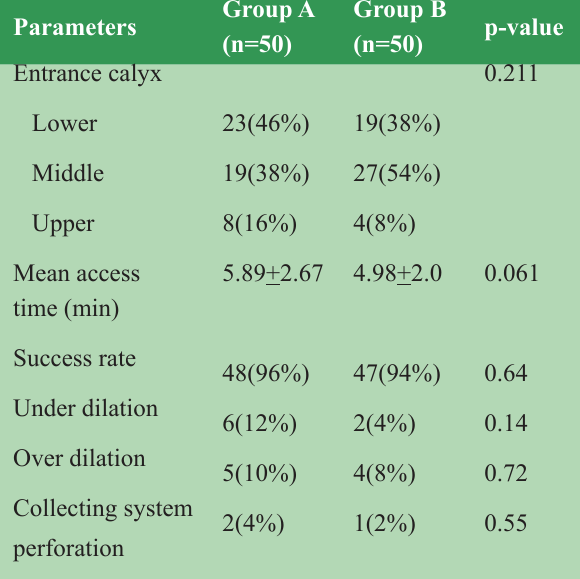
Table 2. Intraoperative variables